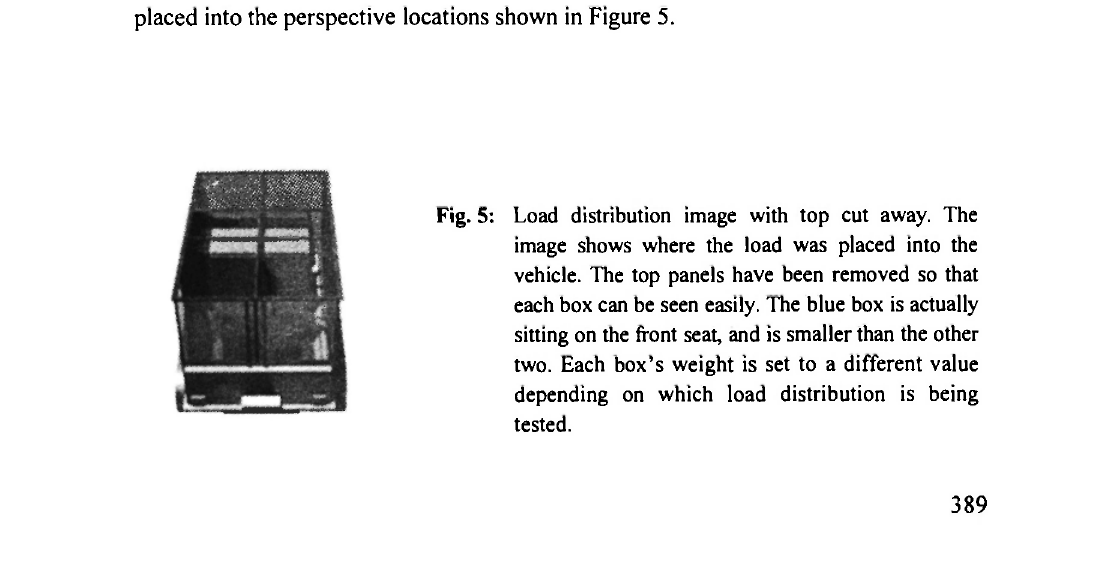
Fig. 5: Load distribution image with top cut away. The image shows where the load was placed into the vehicle. The top panels have been removed so that each box can be seen easily. The blue box is actually sitting on the front seat, and is smaller than the other two. Each box's weight is set to a different value depending on which load distribution is being tested.